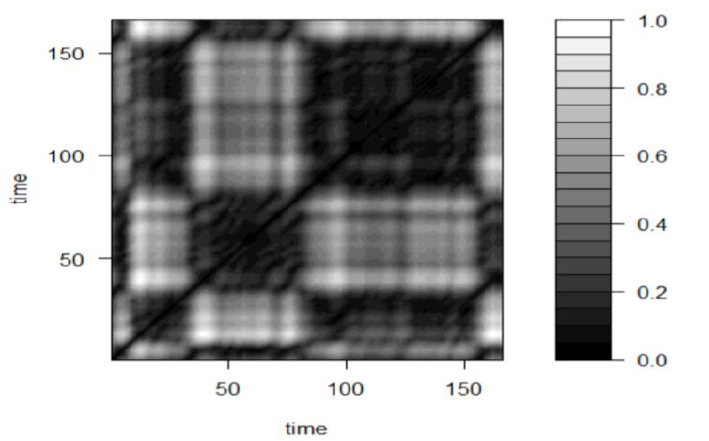
Figure 5: Recurrence plot-Food index; Source: